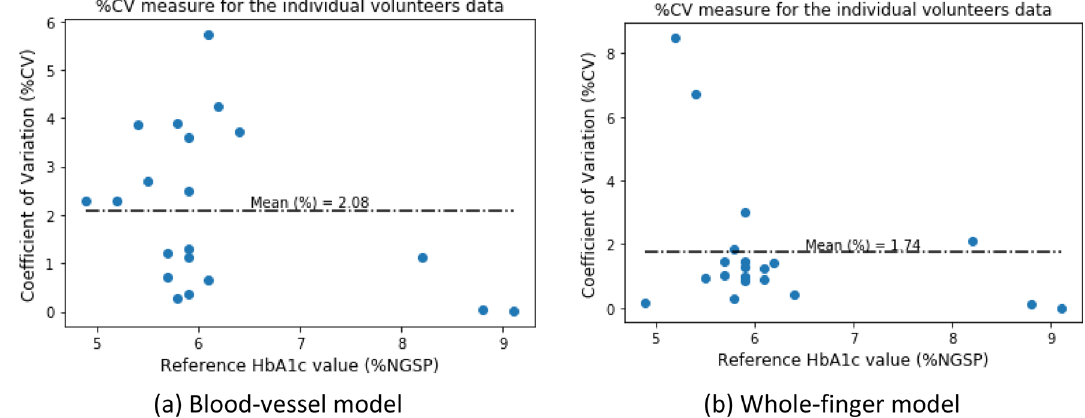
Figure 12. Percent coefficient of variation for the reference and estimated %HbA1c values for both models.